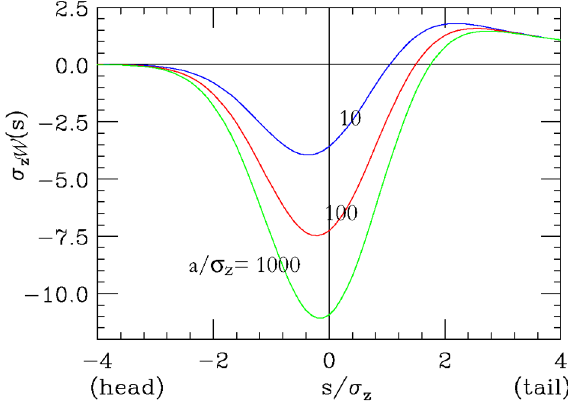
FIG. 4. (Color) For Gaussian bunches, the function (cid:3) three values of a=(cid:3)